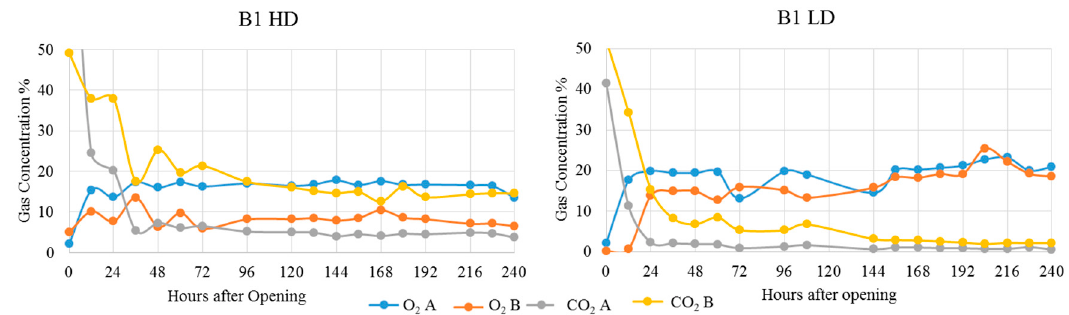
Figure 5. Means of gas concentrations of samples taken from buckets of treatment B1 at two sampling points (A and B); B1 = silage treated with biological inoculant 1, HD = high density, LD = low density.